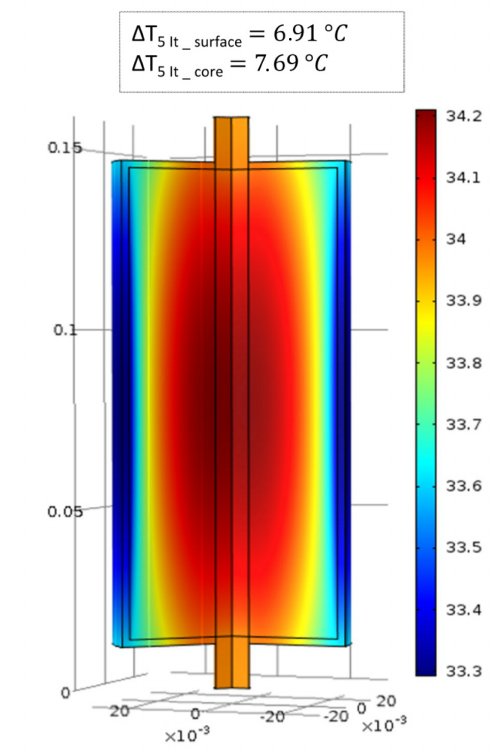
Figure 12. Temperature distribution at the end of a 5 I internal